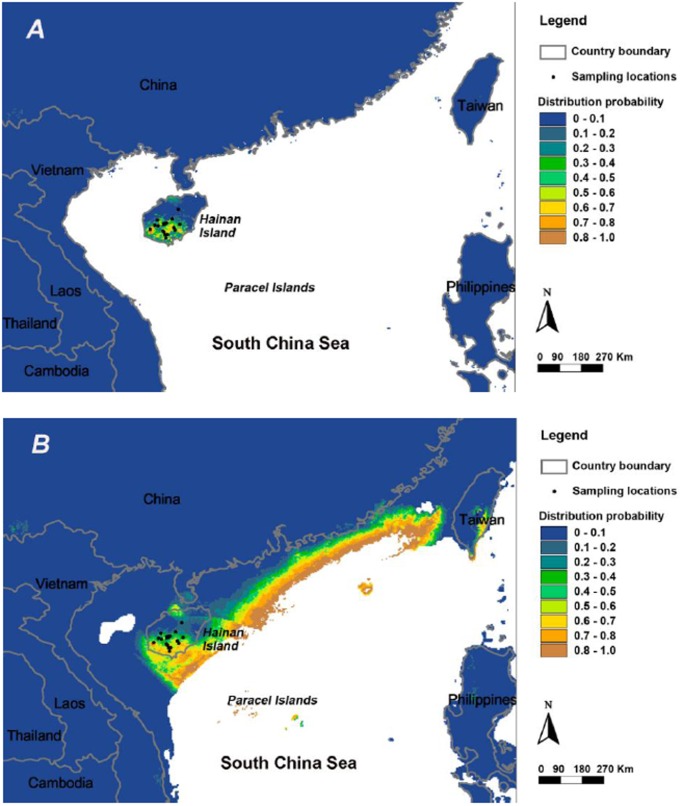
Map of the predicted distribution of A. ardens under current (A) and last glacial maximum (B).Distributions are shown from 0 (blue) and 1 (brown) probability. Note that the continental margin depicted on the LGM map differs from the other because sea level was lower during glacial periods.